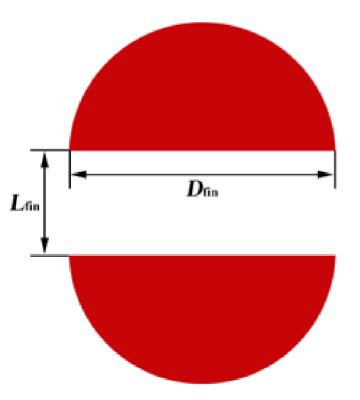
Figure 4. Schematic diagram of split pin-fin